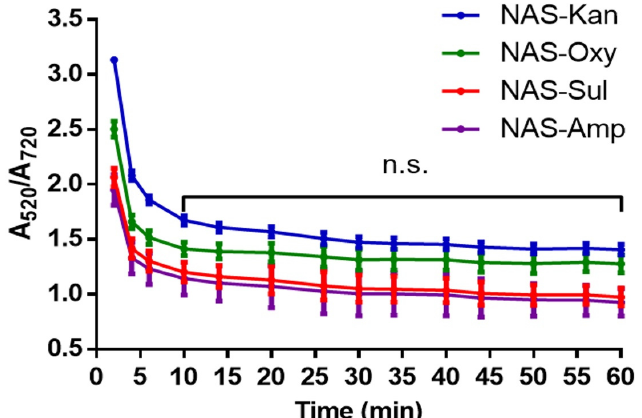
Figure 4. Kinetics of the aggregation of AuNPs in response to NAS detecting kanamycin (red), oxytetracycline (green), sulfadimethoxine (blue) and ampicillin (purple) upon the addition of NaCl. The results were averaged from 3 independent experiments for each NAS ( n = 3). Non-significant differences are shown as n.s. Data were analyzed using a nonparametric Mann–Whitney U test. The previously determined parameters were employed in antibiotic detection exper- iments. As shown in Figure 5, the NAS allowed for the discrimination of trace-level con- centrations of the antibiotics kanamycin (0, 37.5, 75 and 150 μ g/L), oxytetracycline (0, 50, 100 and 200 μ g/L), sulfadimethoxine (above 12.5 μ g/L) and ampicillin (above 1 μ g/L).